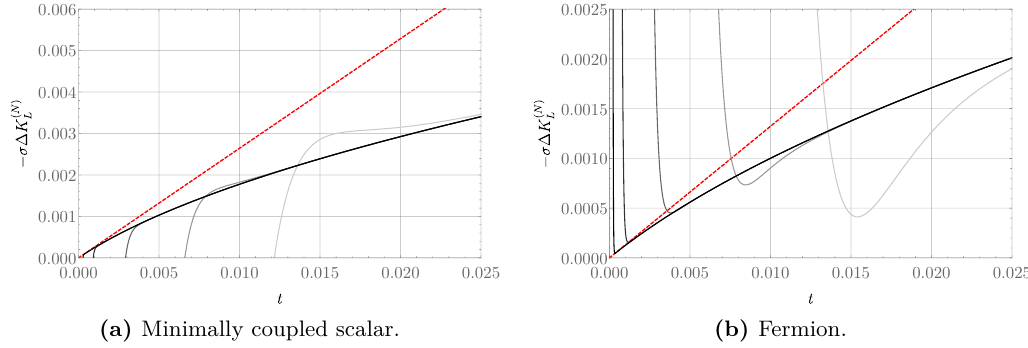
Figure 15. Small- t behavior of the truncated differenced heat kernel ∆ K ( N )